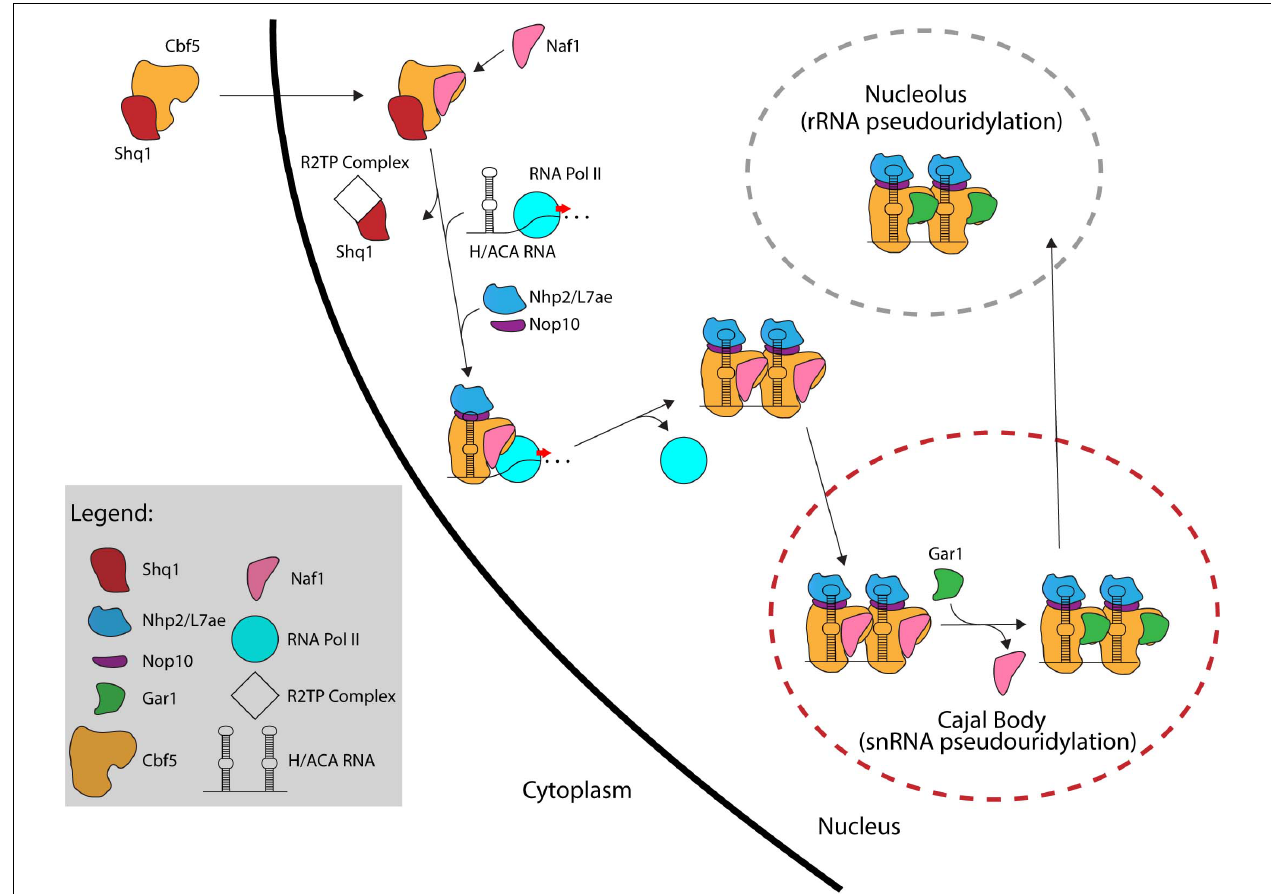
FIGURE 4 | The assembly pathway of eukaryotic H/ACA sRNPs. Several assembly factors like Shq1, Naf1, and the R2TP complex assist in the assembly of eukaryotic H/ACA sRNPs. In contrast, archaeal H/ACA sRNPs are thought to self-assemble without the help of additional